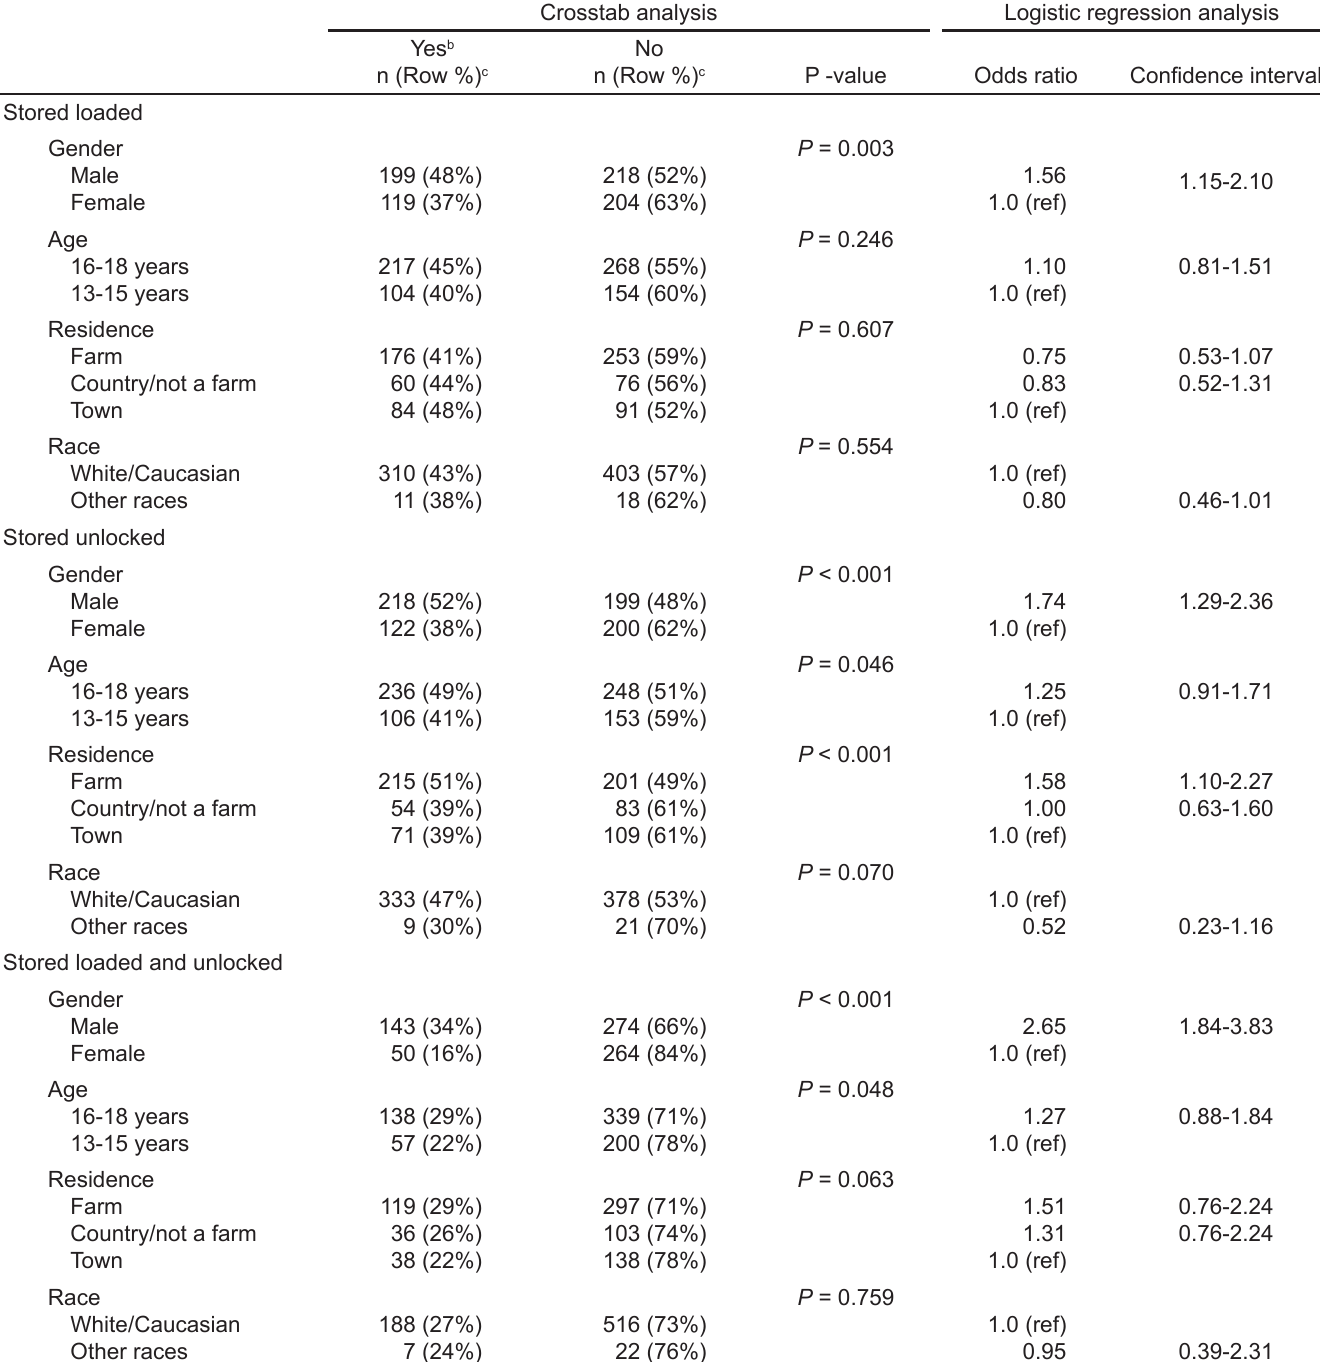
Table 6. Bivariate and multivariable logistic regression analyses regarding the storage of handguns in the homes of adolescent survey respondents.